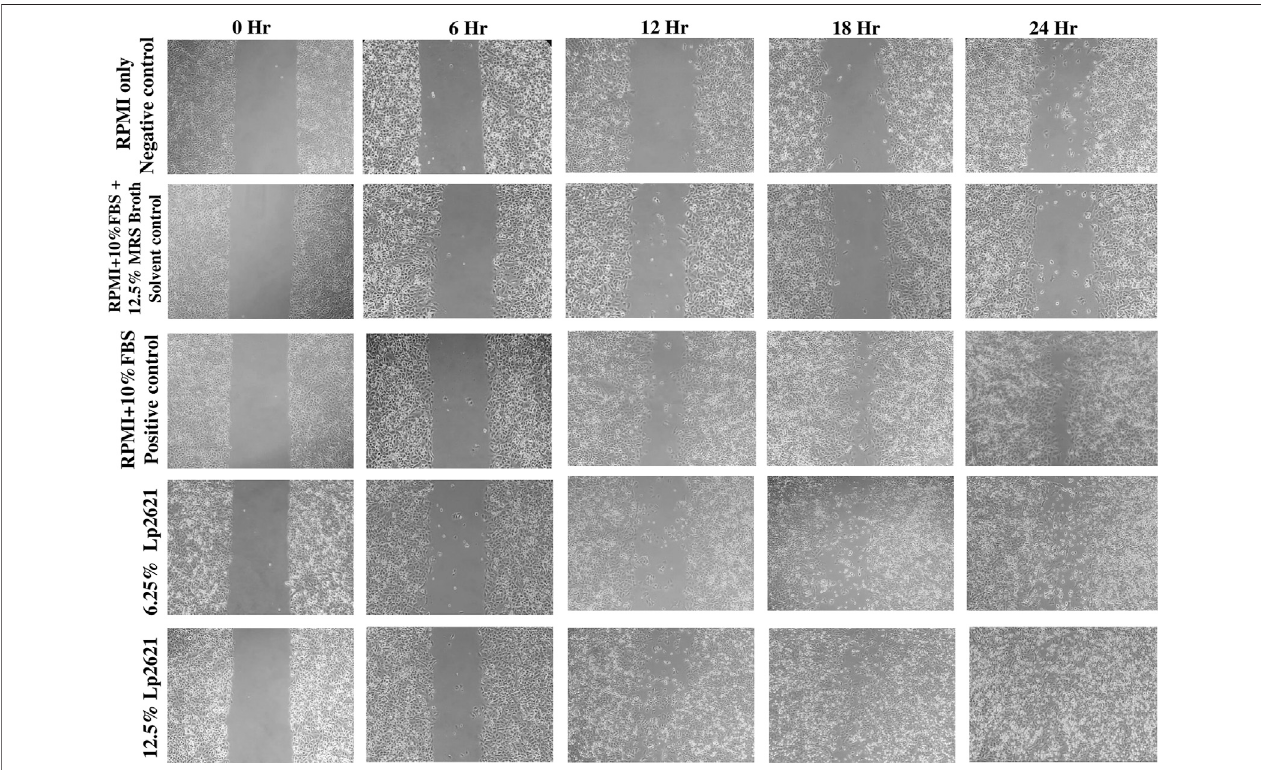
FIGURE 3 | Representative microscopic images of the wound area in A549 epithelial cells in scratch assay after 0, 6, 12, 18, and 24 h incubation. Images were taken using a trinocular microscope having an in-built camera. Analysis was done using ImageJ software.